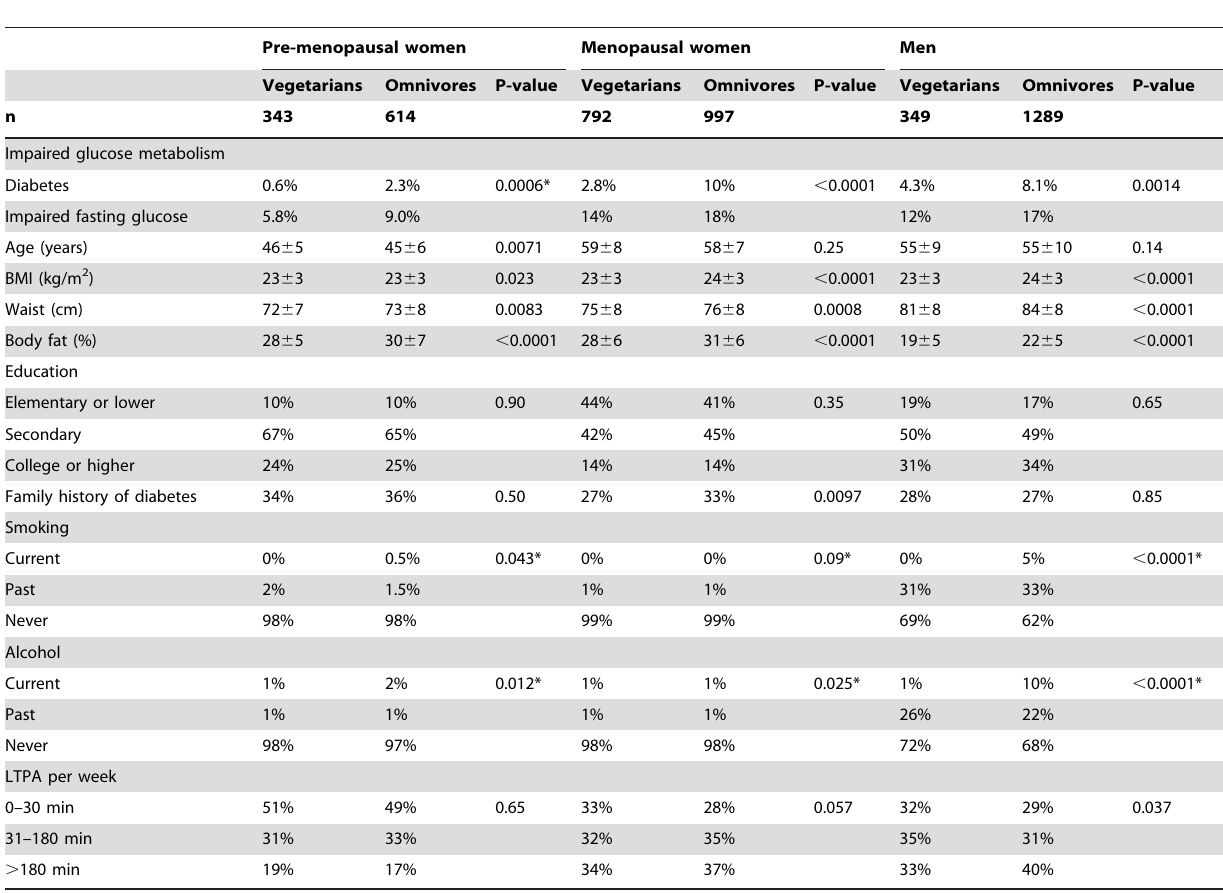
Table 2. Crude prevalence of impaired glucose metabolism and other characteristics of vegetarians and